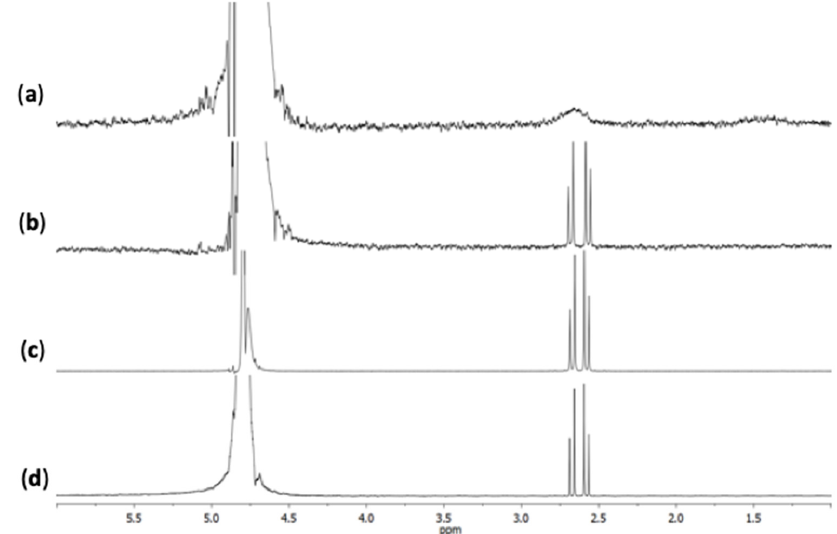
Figure 3. NMR spectra of ( a ) hybrid nano-systems GO-AuNP pellet 2, 3.5 × 10 − 8 M; ( b ) AuNPs pellet 2, 3.5 × 10 − 8 M; ( c ) GO 0.025 mg/mL in 3.09 × 10 − 3 M sodium citrate solution ( d ) 3.09 × 10 − 3 M sodium citrate